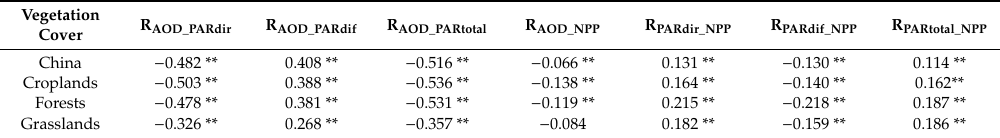
Table 3. Correlation coe ffi cients among AOD, PAR and NPP for croplands, forests, and grasslands. Vegetation Cover